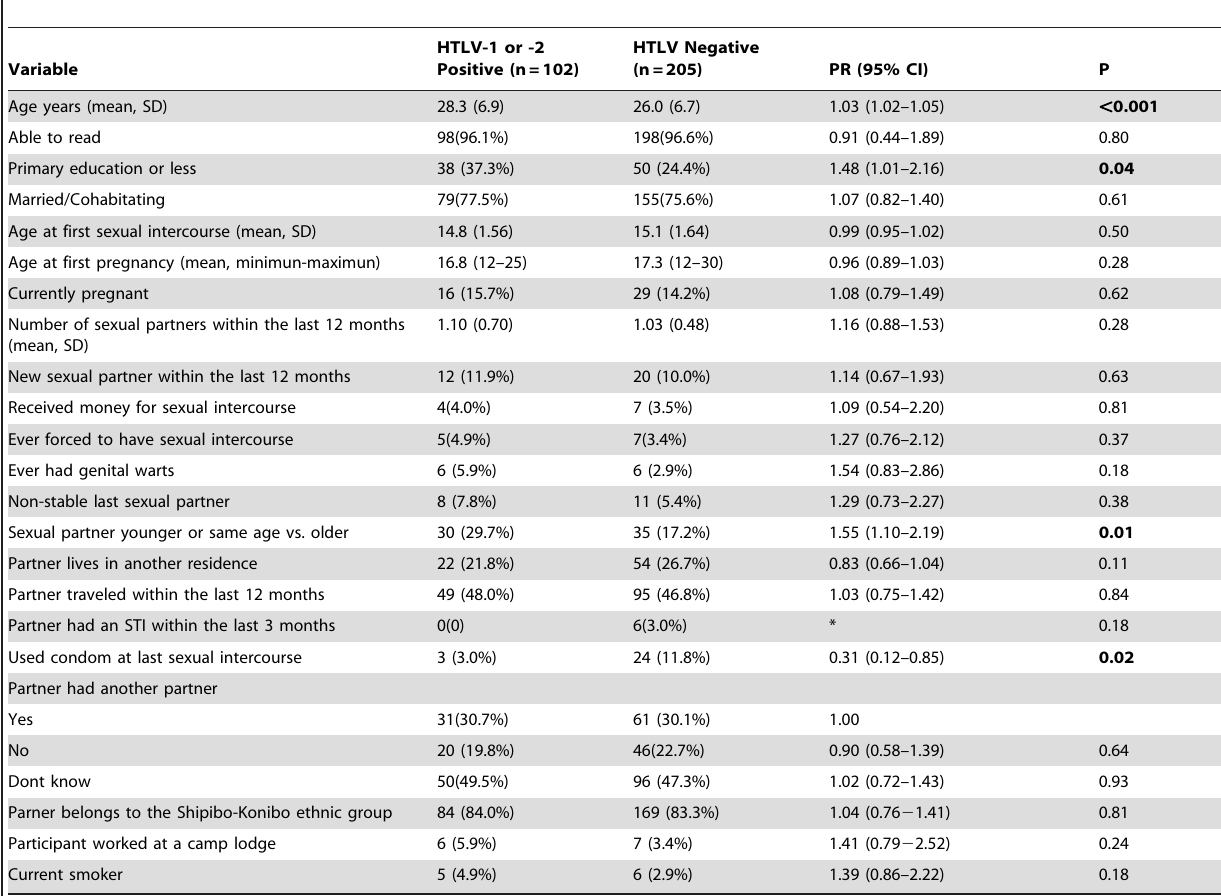
Table 1. Demographic characteristics and sexual behaviors among women with and without HTLV Infection.